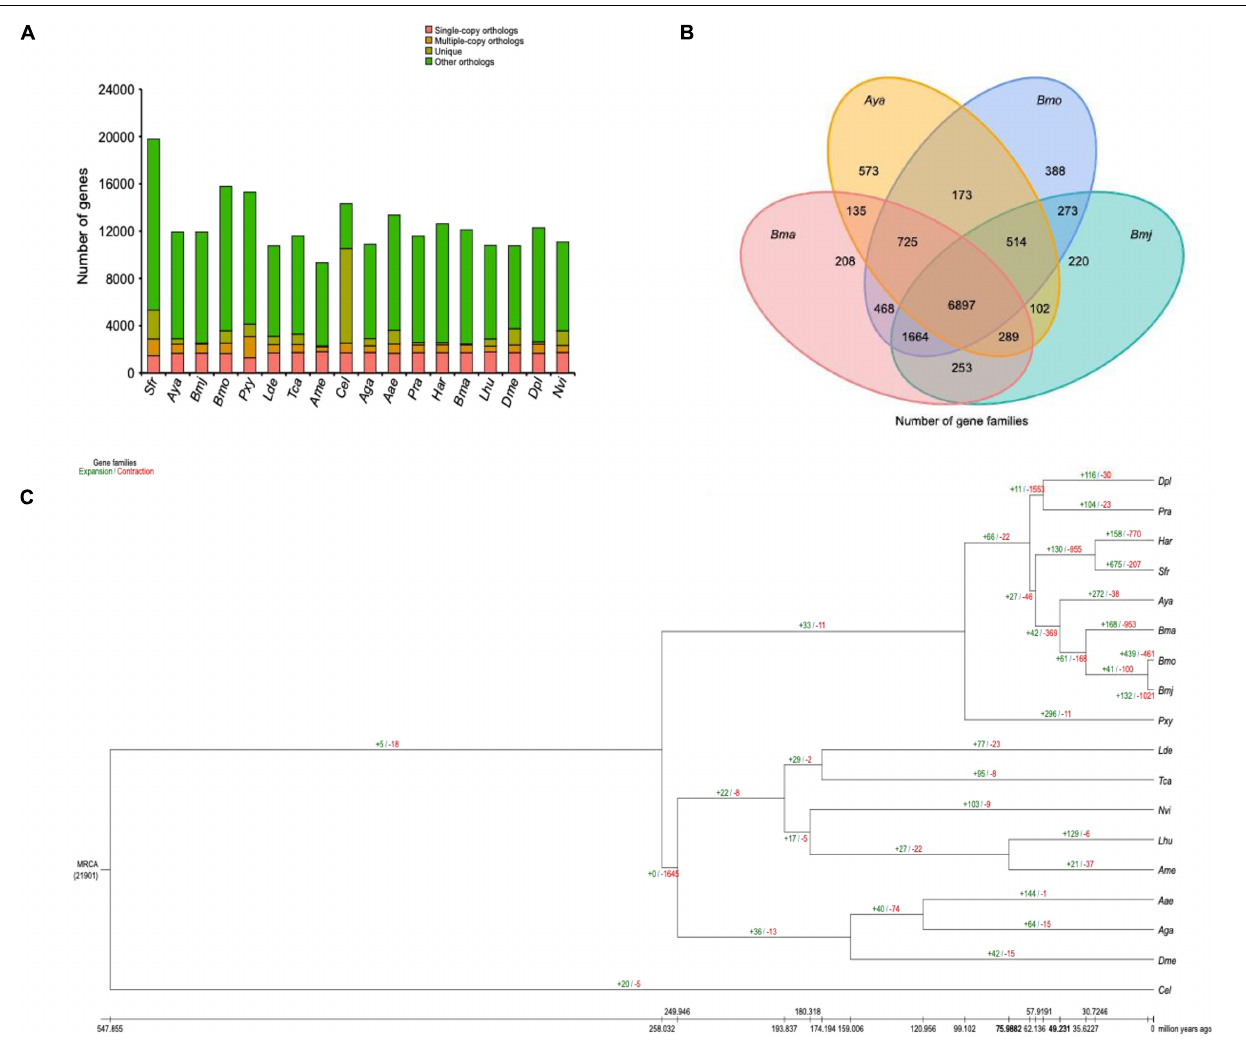
FIGURE 3 | Gene family and phylogenetic and divergence analyses of Bombyx mori and other representative insect genomes. (A) Clusters of orthologous and paralogous gene families in B. mori and 17 other sequenced insect genomes. The y -axis indicates the number of gene families, while the x -axis indicates the 18 species. The total number of gene families was 21,951, of which the number of single-copy orthologs was 620. (B) Venn diagram representing the distribution of shared gene families among B. mori and three other silkworms ( Bma , Aya , Bmo , and Bmj ). (C) Gene family expansions and contractions estimated by CAFÉ v3.0 and CAFE_fig. The green and red numbers indicate expanded and contracted gene families,